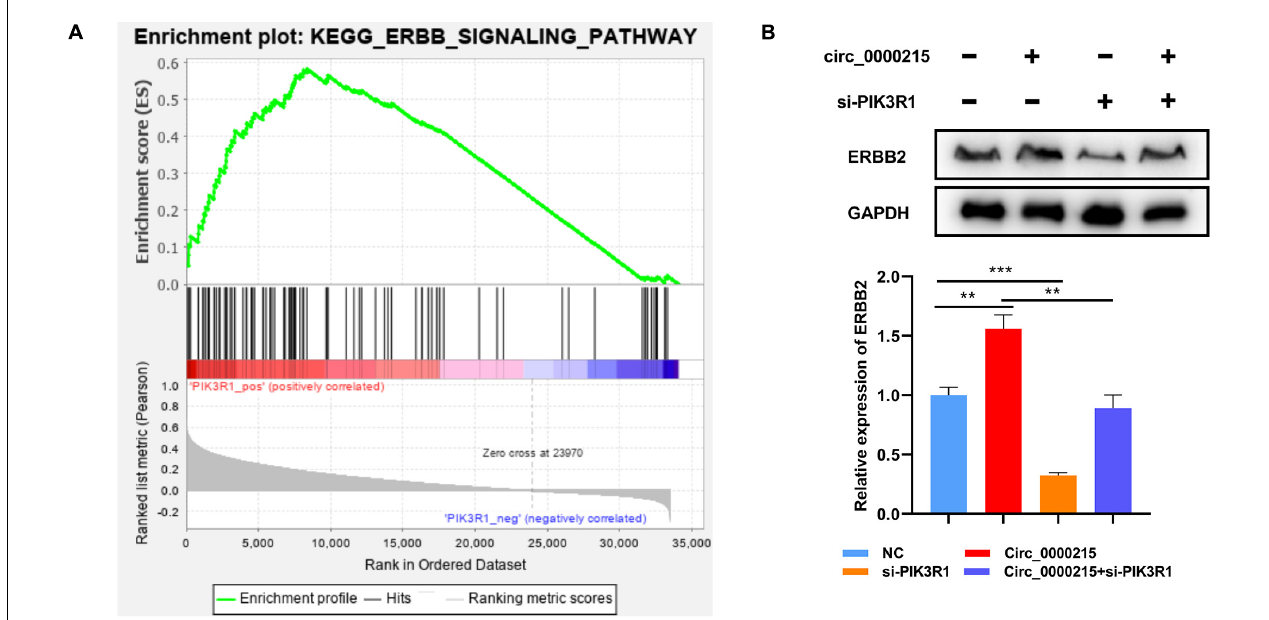
FIGURE 9 | Circ_0000215 increases ERBB expression in NPC cells via PIK3R1. (A) GSEA revealed that PIK3R1 expression was probably associated with the ERBB signaling pathway. (B) Western blotting was performed to detect the effects of circ_0000215 overexpression and PIK3R1 knockdown on ERBB2 expression. The significance of difference was determined by one-way ANOVA. ** P < 0.01 and *** P < 0.001. Data from three independent experiments were expressed as mean ± standard